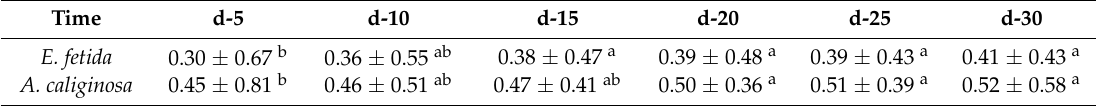
Table 4. Cd LC50 bioaccumulation factor (BAF) on earthworms with the respect to the time. Time